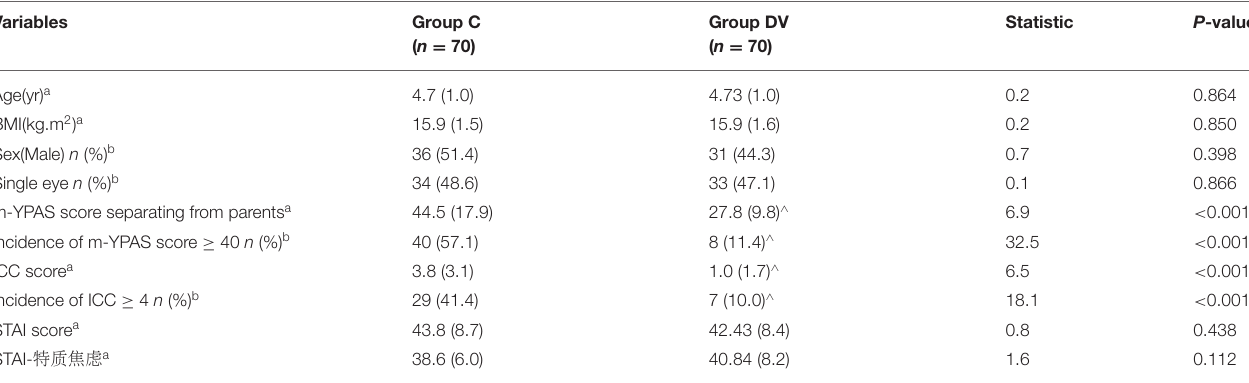
TABLE 1 | Subject characteristics and clinical